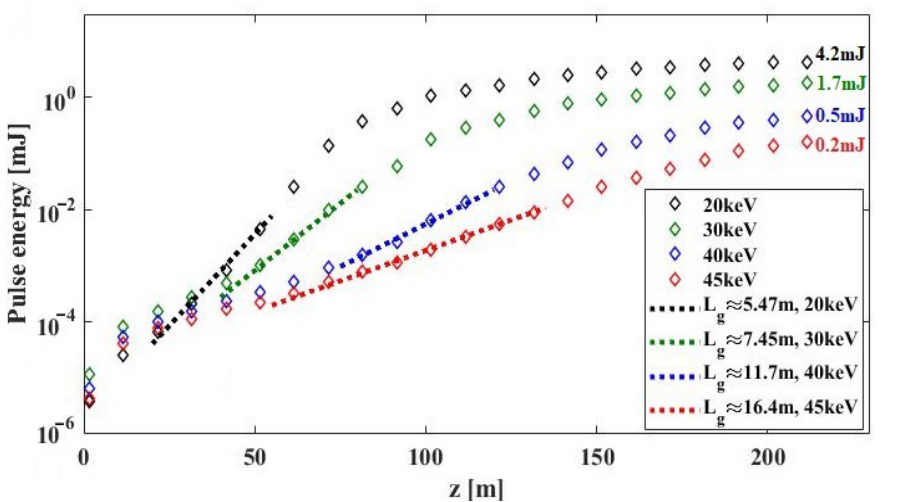
Figure 9. FEL performance in the sub-ångström regime with optimized electron bunches produced at a cathode accelerating gradient of 56.3 MV/m at a final beam energy of 17.5 GeV. Dashed lines correspond to exponential fits to the gain curves. The inset numbers show the obtained pulse energy by the end of the undulator beamline. For each case, 30 simulations are performed with random noise seeds. The statistical standard deviations of the achievable SASE intensities are up to